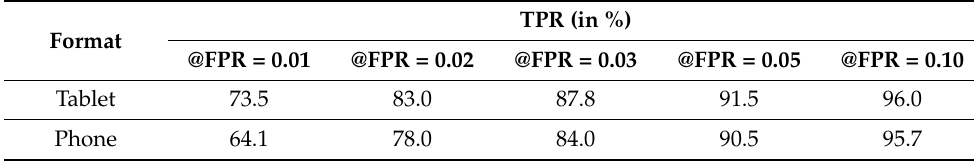
Figure 8. ROC curves for mixed attack types for both device formats. Stimulus trajectory: ( a ) Lines or Curves challenge for 5 s; ( b ) composite challenge for 6 s. Table 6. TPR at various FPR settings for mixed attack (trajectory: composite, duration: 6 s).